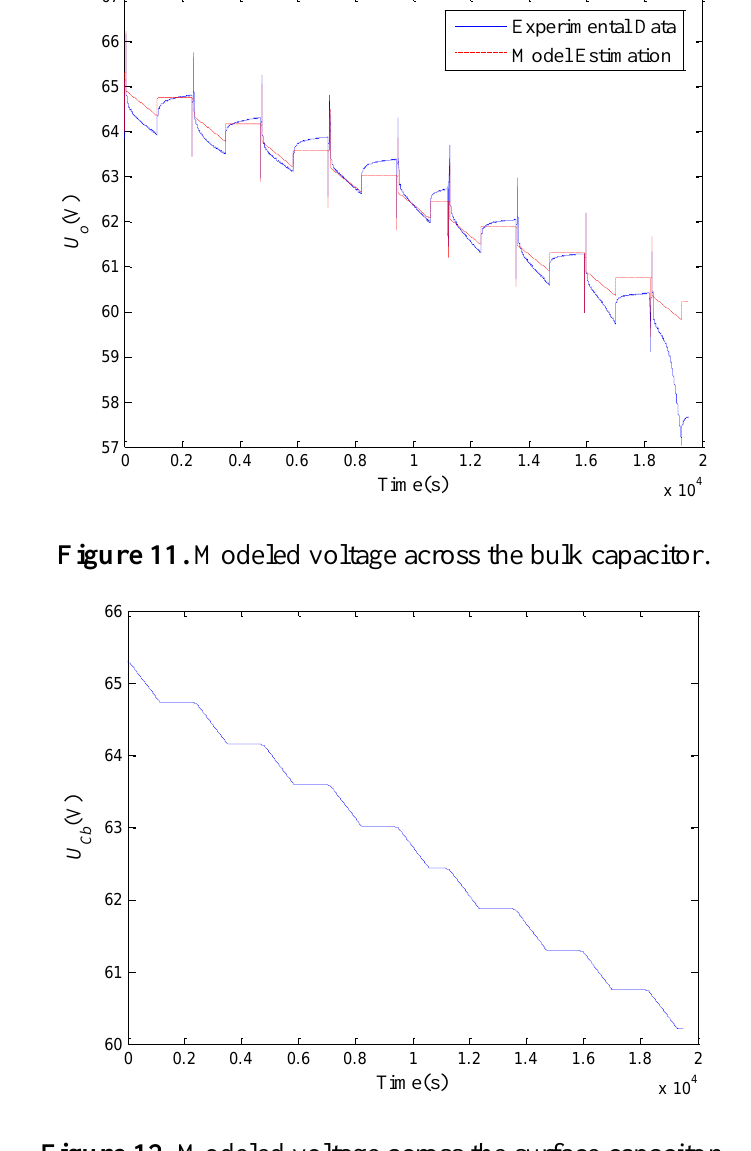
Figure 12. Modeled voltage across the surface